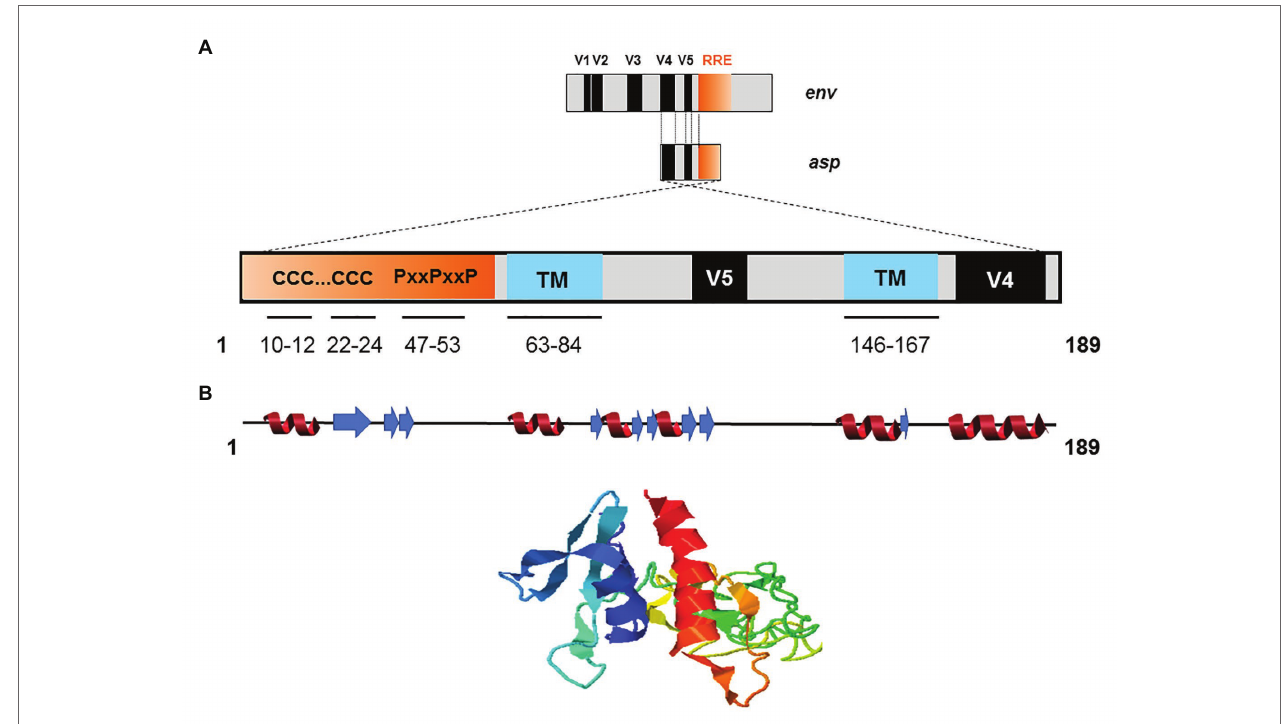
FIGURE 4 | Schematic representation of the primary, secondary, and tertiary structures of ASP. (A) Conserved cysteine triplets (CCC), Proline-rich SH3 domain- binding motifs (PxxPxxP), putative transmembrane (TM) domains. The theorical molecular weight of ASP is 20235.26 Da (reference sequence HXB2 using Predict Protein software). Using PONDR VL3, PONDR VSL2, and PONDR VLXT software, it was predicted that, respectively, 9.52, 13.76, and 18.52 of ASP amino acids exist in a disordered state. Only four regions of ASP are expected to exist in disordered states (residues 1–2; 4–4; 44–55; 97–116 predicted using PONDR VSL2 software). (B) Predicted secondary (alpha-helix in red and beta-sheet in blue) and tertiary structures of ASP. The reference sequence of ASP was submitted to the I-Tasser server (https://zhanglab.ccmb.med.umich.edu/I-TASSER/) to obtain a model via a threading prediction. C-Score = − 4.07, estimated TM- score = 0.28 ± 0.09, estimated RMSD = 15.0 ± 3.5